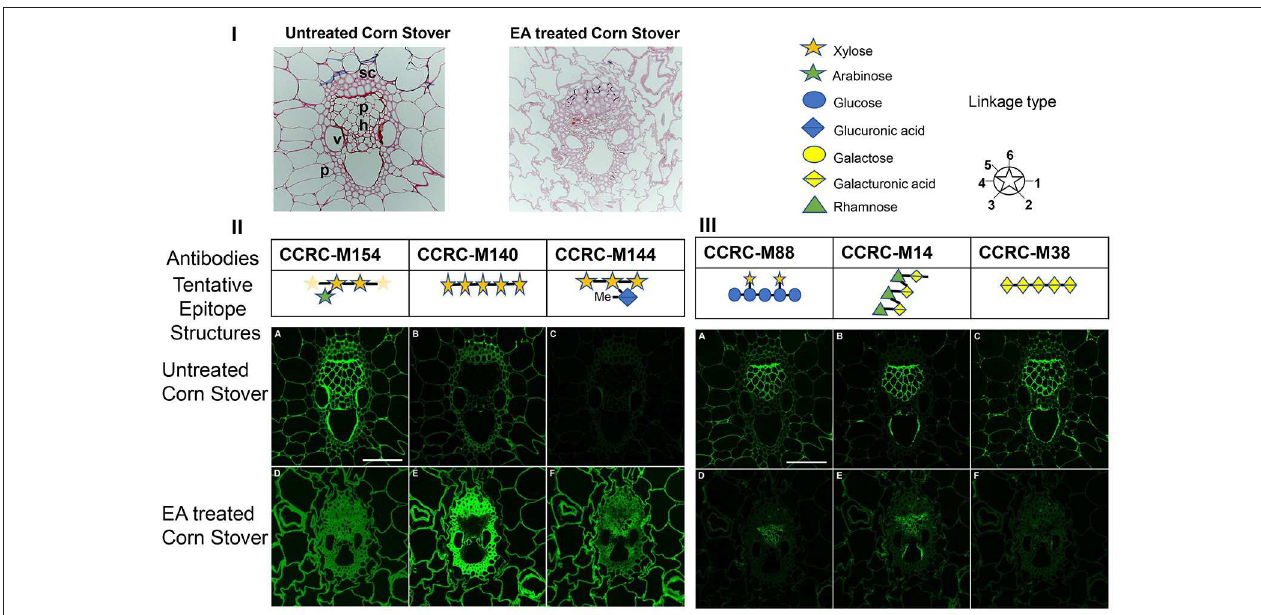
FIGURE 5 | Imaging studies on untreated and ammonia treated corn stover cell walls. Here, (I) lignin staining indicates changes in the wall. Safranin stains lignin that is more concentrated in the vascular bundle in the untreated corn stover samples compared to more uniform distribution and less staining after EA pretreated samples. Parenchyma (p), phloem (ph), schlerenchyma (sc), vessel (v); (II) immunofluorescent labeling of untreated (A, B, C) and EA pretreated (D, E, F) of corn stover stems images by using xylan-directed antibodies. CCRC-M154 (in A and D) recognizes arobinoxylans. CCRC-M140 (in B and E) recognizes long stretches (DP > 4) of xylan backbone. CCRC-M144 (in C and F) recognizes 4-O-methyl glucoronoxylans. Bar in A equals to 100 micron and applies to all images; and (III) immunofluorescent labeling of untreated (A, B, C) and EA pretreated (D, E, F) of corn stover stems images by using xyloglucan and pectin-directed antibodies. CCRC-M88 (in A and D) recognizes non-fucosylated xyloglucans. CCRC-M14 (in B and E) recognizes RG-I backbone. CCRC-M38 (in C and F) recognizes HG backbone. Bar in A equals to 100 micron and applies to all